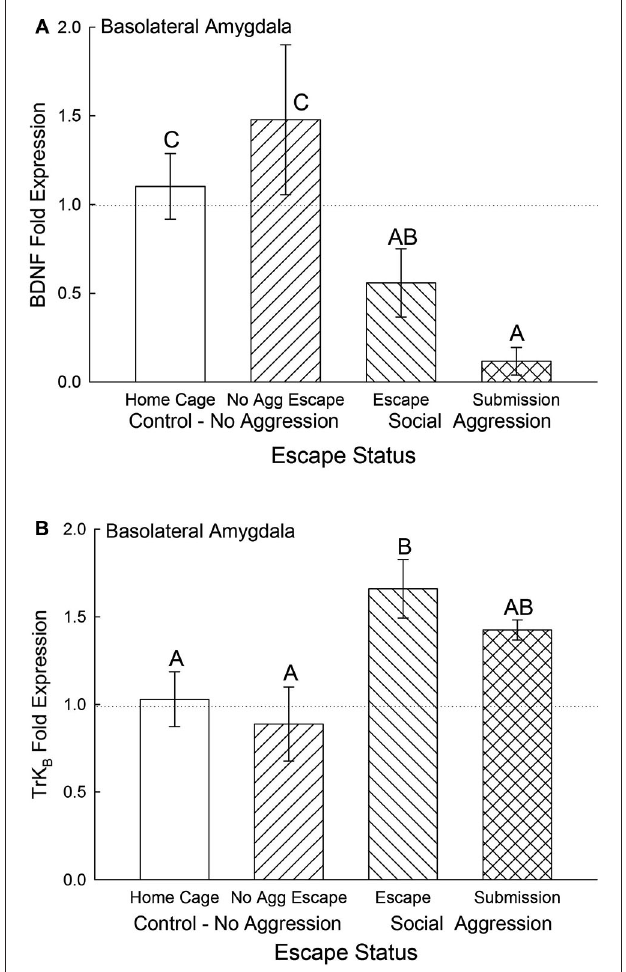
FIGURE 6 | Submissive mice exhibit decreased CeA BDNF mRNA . Mean ( ± SEM) fold expression of (A) BDNF and (B) Trk B mRNA from CeA on test day (CS+, US − ) for cage controls (clear bars; BDNF N = 14; Trk B N = 14), after SAM exposure in mice not receiving aggression (bars with left hatch; BDNF N = 6; Trk B N = 6), after SAM plus social interaction in mice that escaped aggression during training (right hatch; BDNF N = 8; Trk B N = 8) and mice that were submissive during training (cross hatch; BDNF N = 5; Trk B N = 5). Letters above the bar (A, B) signify statistical significance ( p < 0.05), such that bars that do not share a common letter (e.g., BDNF No Aggression Escape = B vs. Submission = A) are significantly different, and those that do share a letter (e.g., BDNF Home Cage = B vs. Escape = B) or have no letters at all are not.